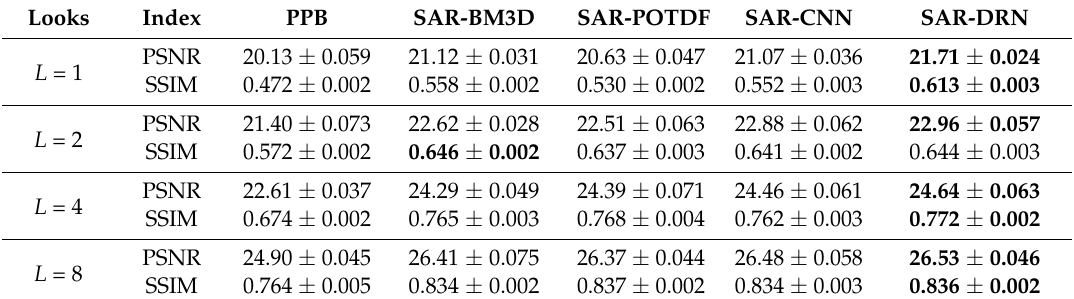
Table 4. Mean and Stand Deviation Results of PSNR (dB) and SSIM for Highway with L = 1, 2, 4, and